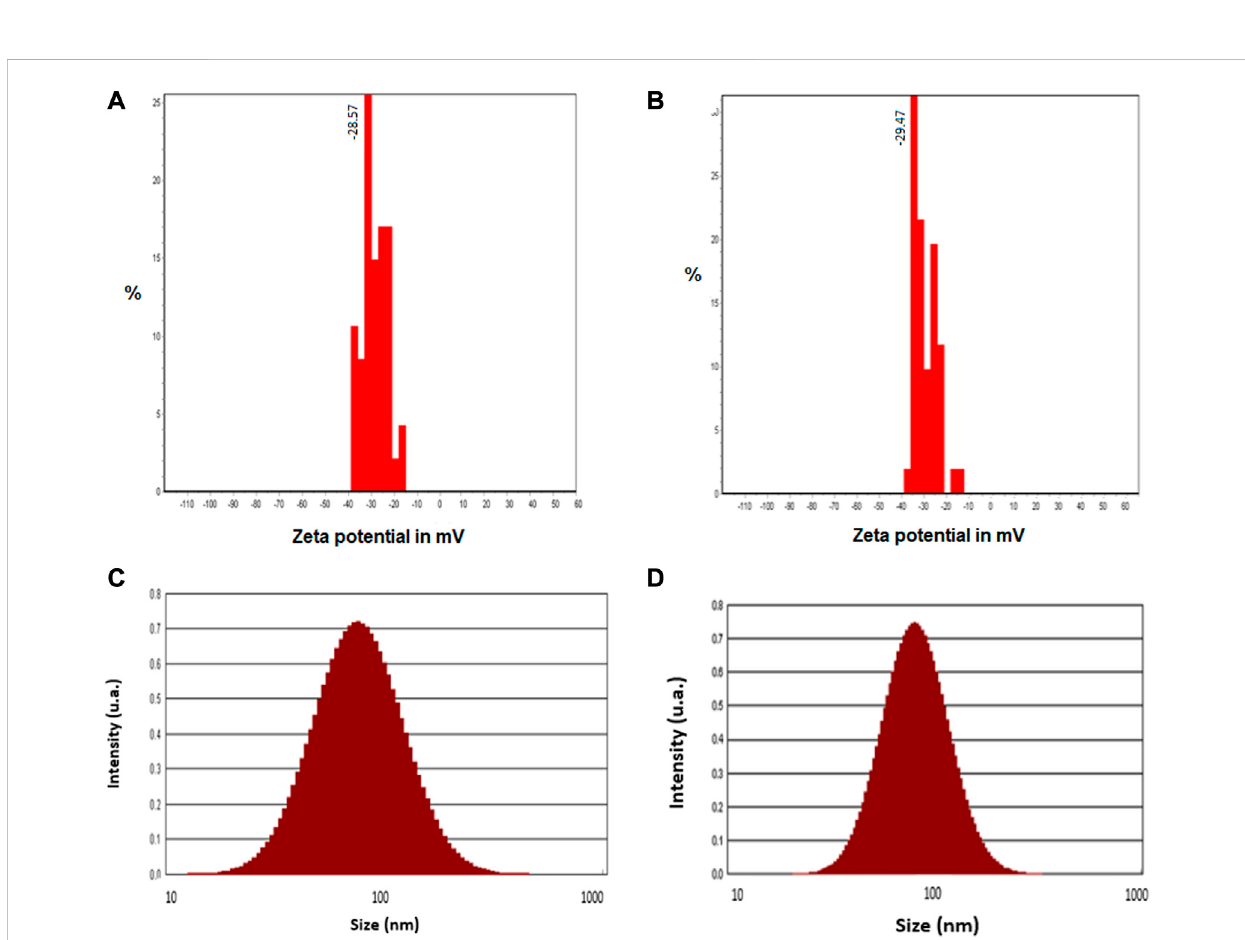
Zeta potential histograms (A, B) and particle size distribution pattern (C, D) of crude (A, C) and calcined (B, D)